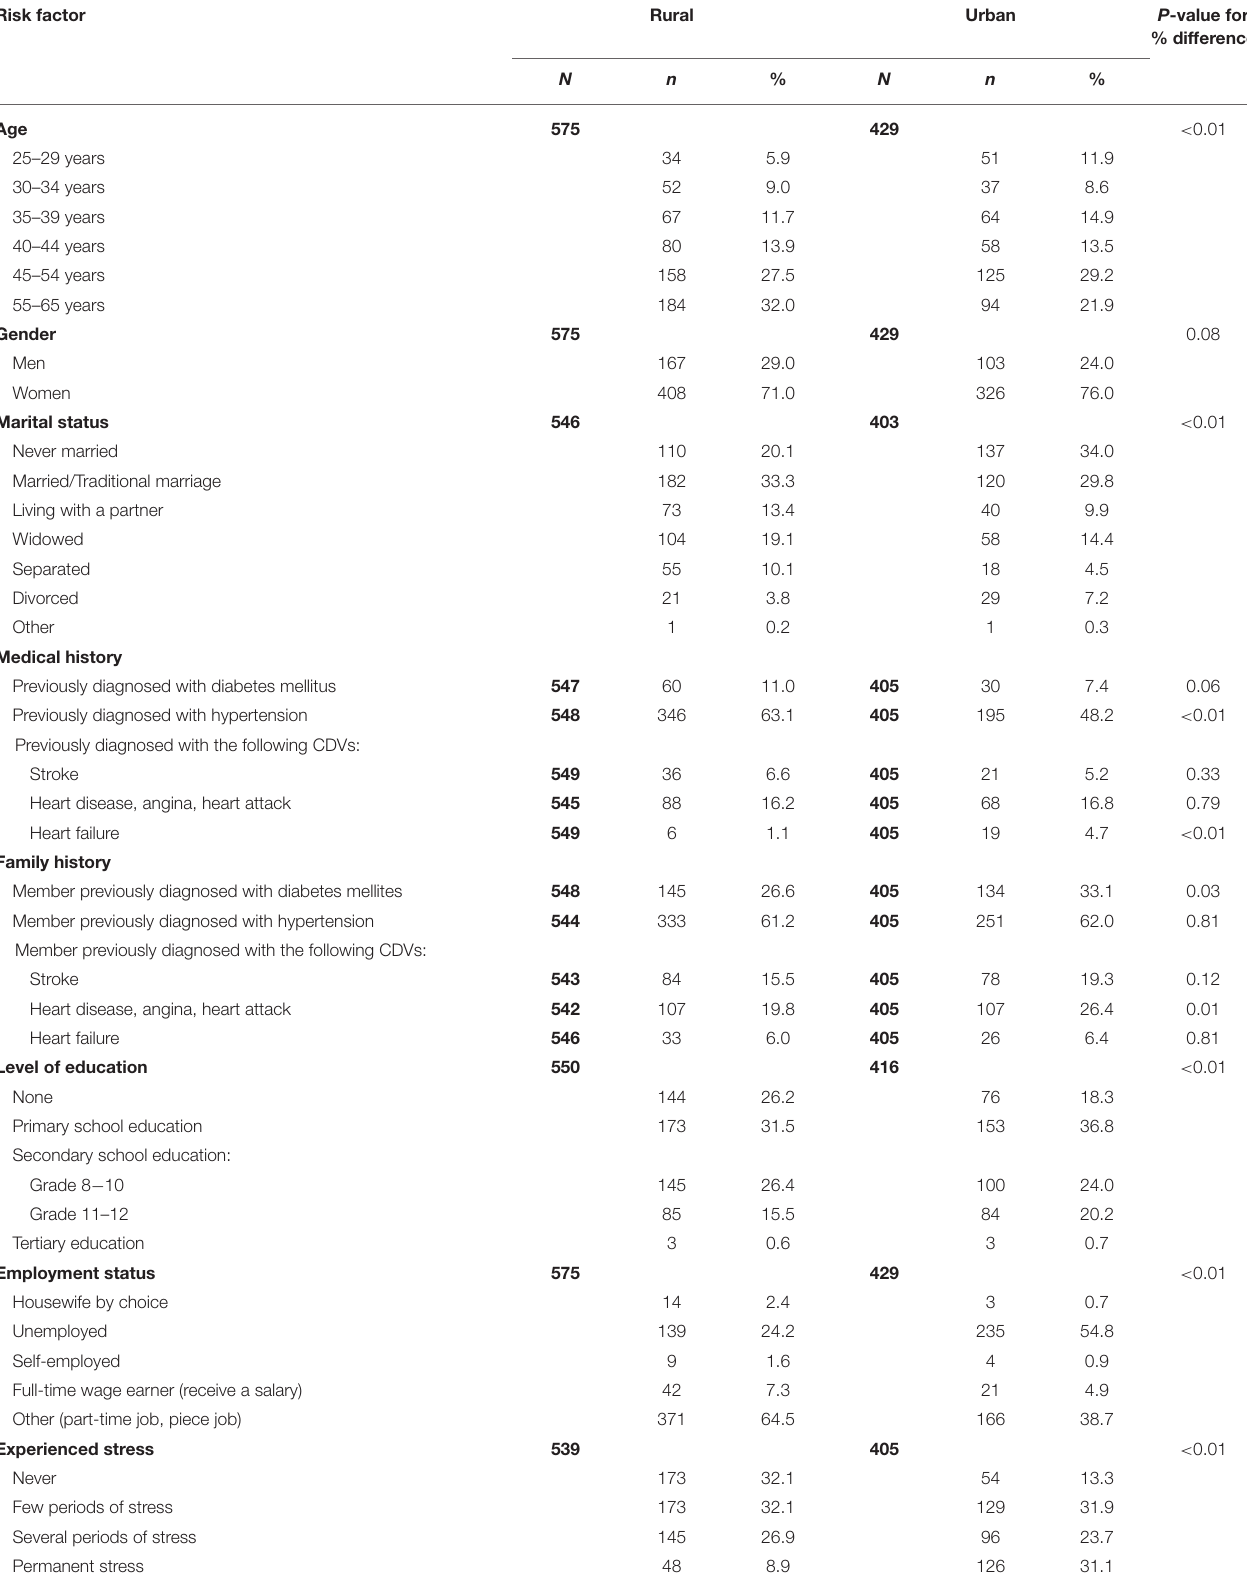
TABLE 1 | Reported socio-demographic/background risk factors of rural and urban participants. Risk factor Rural Urban P -value for